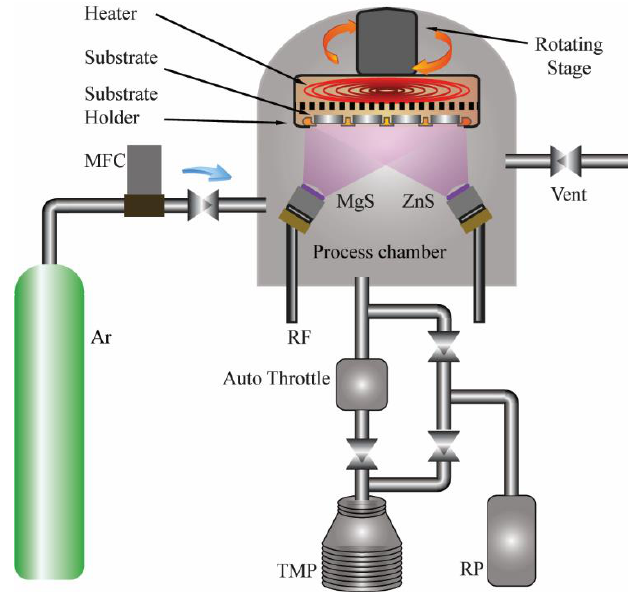
Figure 1. Schematic of the magnetron sputtering system used in ZnMgS thin film deposition.